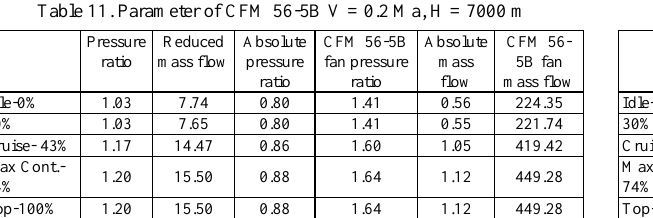
Table 14. Parameter of APS 3200 V= 0.2 Ma, H = 0 m